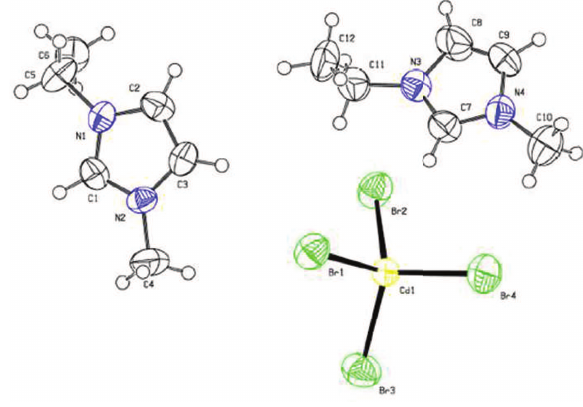
Table 1: Data collection and handling.